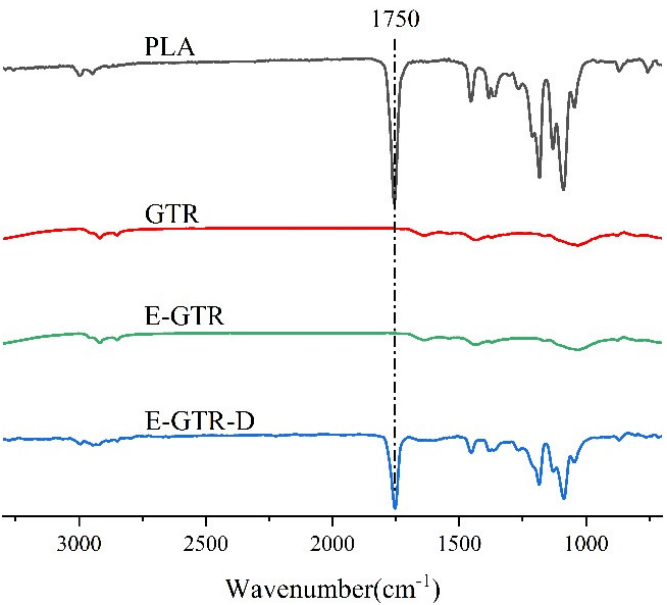
Figure 1. FTIR spectra of neat PLA, GTR, extracted GTR from PLA/GTR (E-GTR) and PLA/GTR with DCP (E-GTR-D).